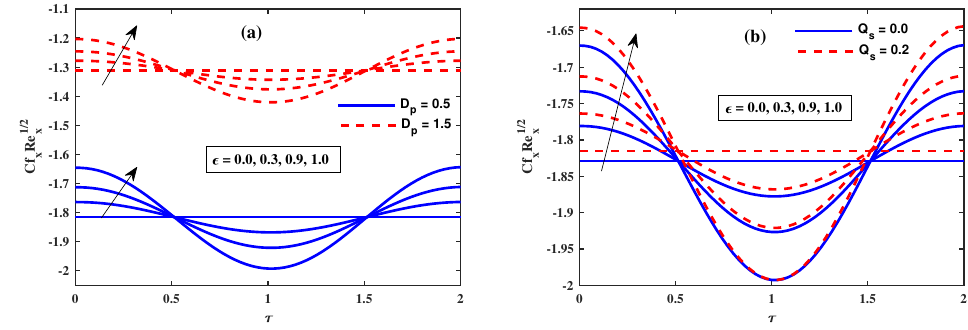
Figure 7. Fluctuation of Cf x Re 1/2 x against (cid:101) (amplitude), ( a ) D p (nanoparticle radius), and ( b ) Q s (heat